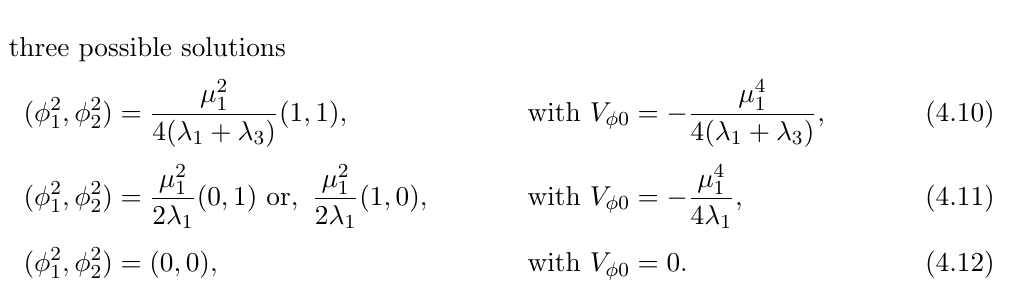
( 1 ; 1). In the lower left panel p 2 (cid:6) (cid:6) ( 1 ; 0) or 1 (0 ; p 2 p 2 (cid:6) (cid:6)